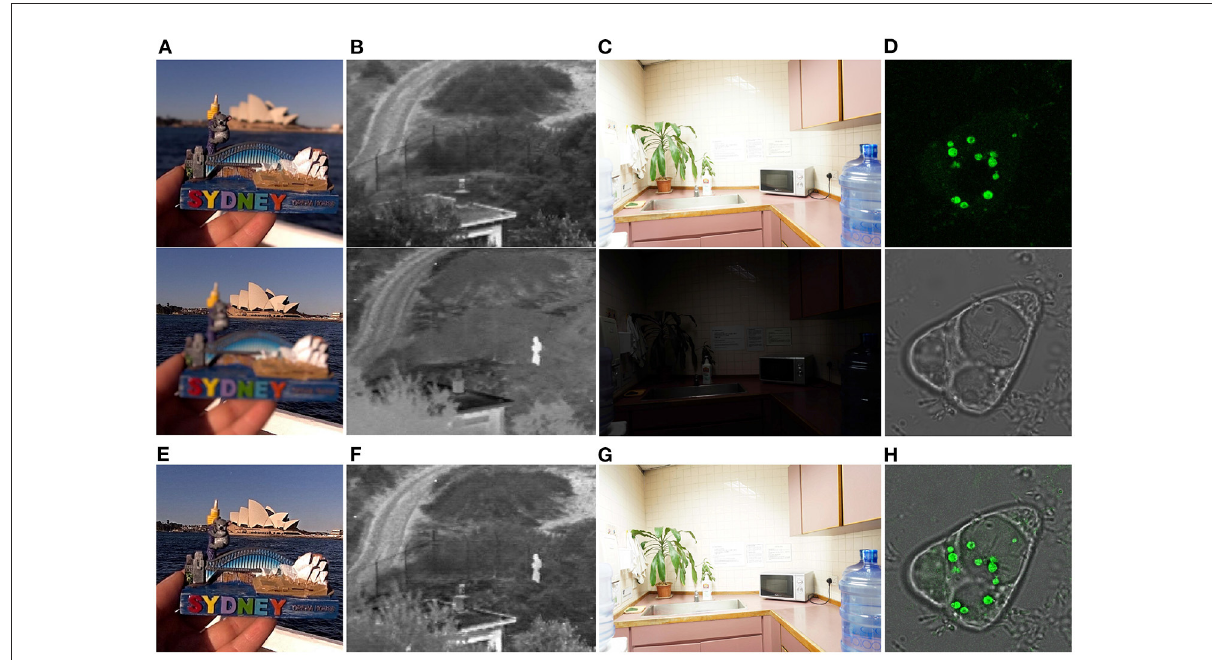
FIGURE9 Our fusion results on other modalities of images. (A) Shows a pair of multi-focus images (Nejati et al., 2015). (B) Shows a pair of visual and infrared images (Toet, 2017). (C) Shows a pair of over- and under-exposed images (Xu et al., 2020b). (D) Shows a pair of green-fluorescent and phase-contrast protein images (Tang et al., 2021). (E–H) are the fusion results of (A–D) ,